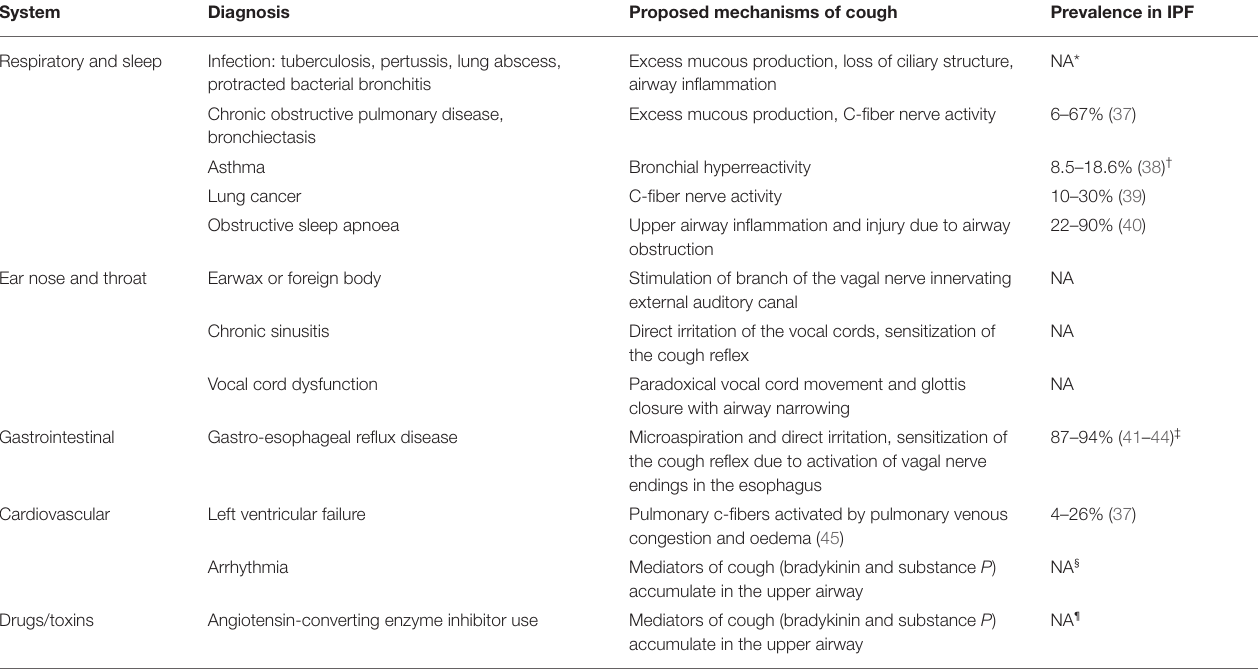
TABLE 1 | Comorbid conditions associated with chronic cough in patients with